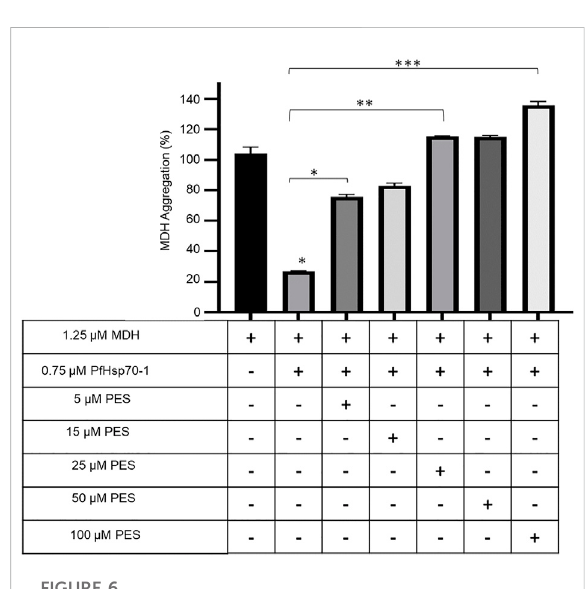
FIGURE 6 PESinhibitstheholdasechaperoneactivityofPfHsp70-1.The effectofPESontheheat-inducedaggregationsuppressionactivity of PfHsp70-1 was monitored by exposing aggregation-prone protein, MDH, to heat stress at 51 ° C in the presence of PfHsp70-1 at equimolar levels and varying levels of PES. The heat- induced aggregation ofMDHwasmonitoredat360 nm.Errorbars indicate the mean generated from three assays conducted using independent PfHsp70-1 protein puri fi cations. Statistical signi fi canceofdifferenceswasdeterminedusingone-wayANOVA and post-hoc test (* p < 0,05; ** p < 0,01; *** p <